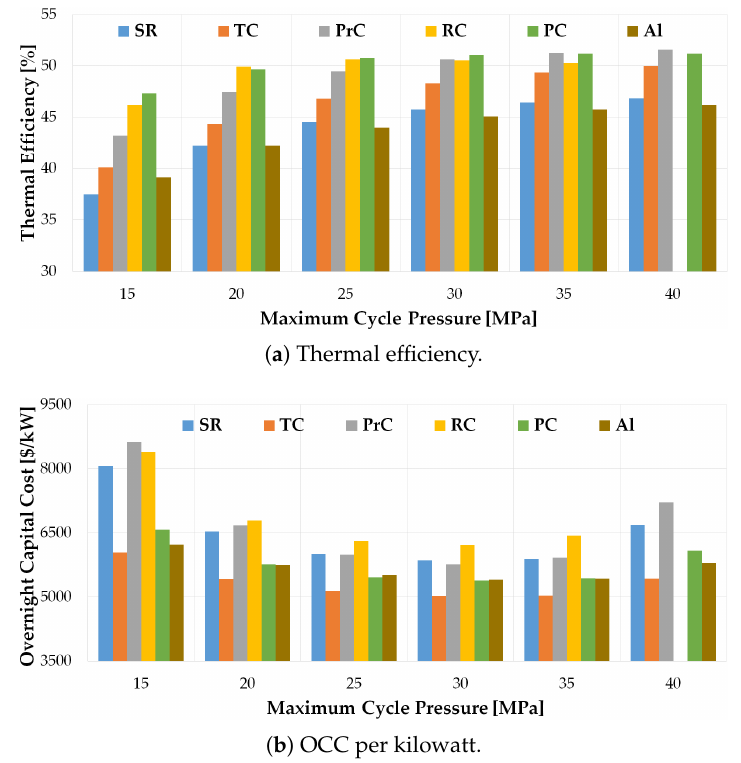
Figure 2. Effect of maximum cycle pressure on thermal efficiency and Overnight Capital Cost per kilowatt. Legend: Simple Recuperated (SR), Transcritical (TC), Partial Cooling (PC), Recompression (R), Pre-compression (PrC) and Allam (Al). Data adapted from